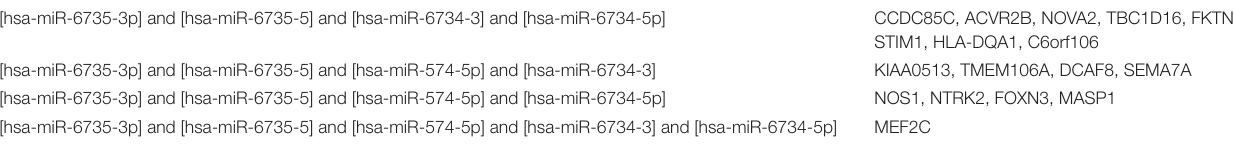
TABLE 7 | Shared targets by the specific microRNA changed between the ADAM6 HOM:DEL group and the rest of the patients. [hsa-miR-6735-3p] and [hsa-miR-6735-5] and [hsa-miR-6734-3] and [hsa-miR-6734-5p] CCDC85C, ACVR2B, NOVA2, TBC1D16, FKTN,